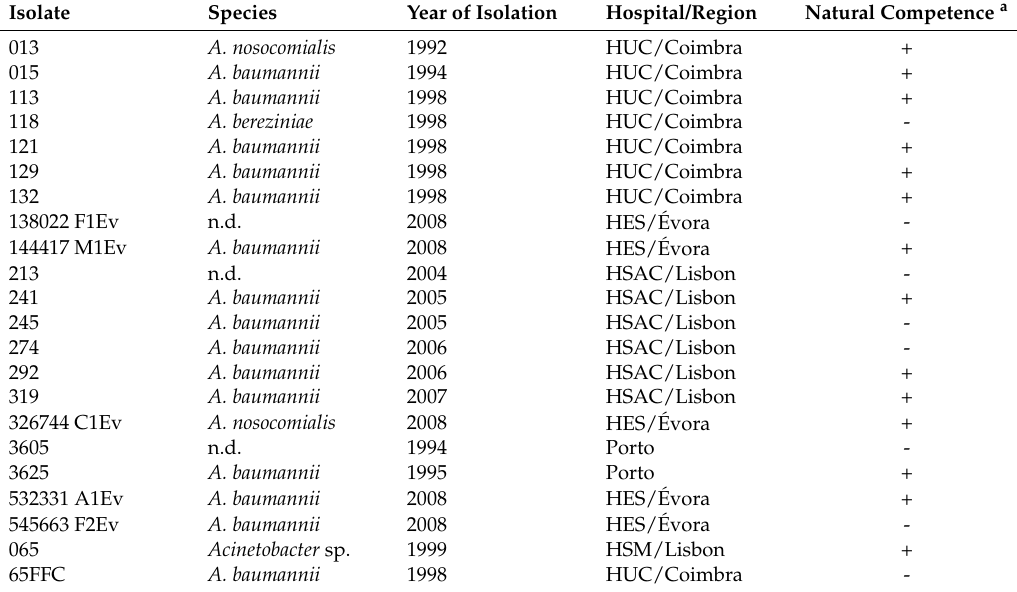
Table 1. Natural competence in clinical Acinetobacter spp.